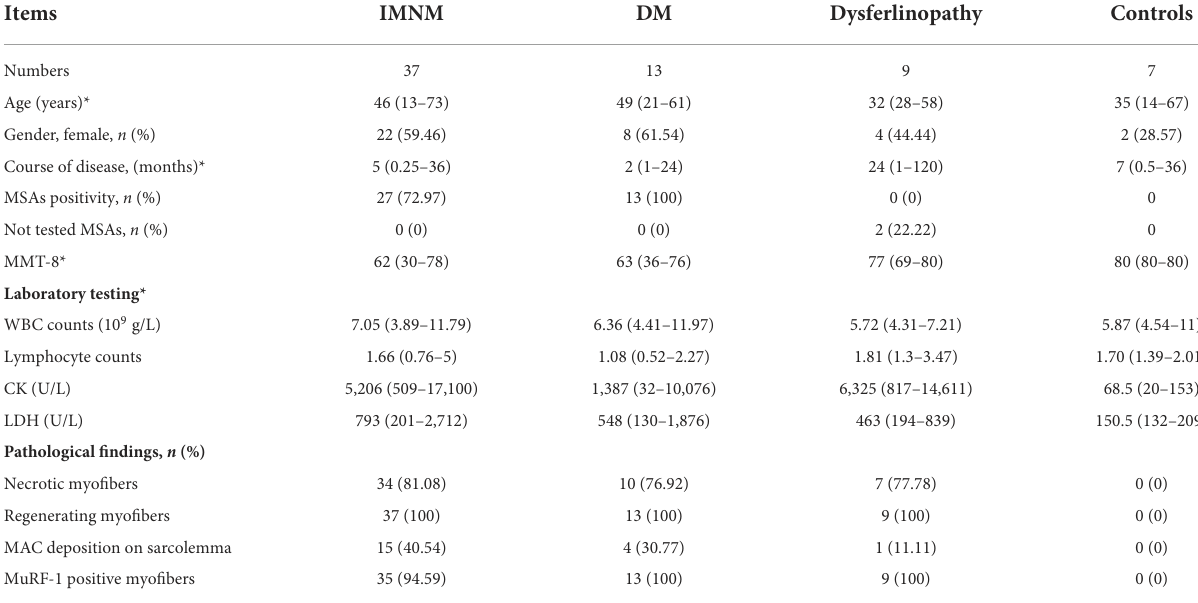
TABLE 1 Clinical and pathological data.